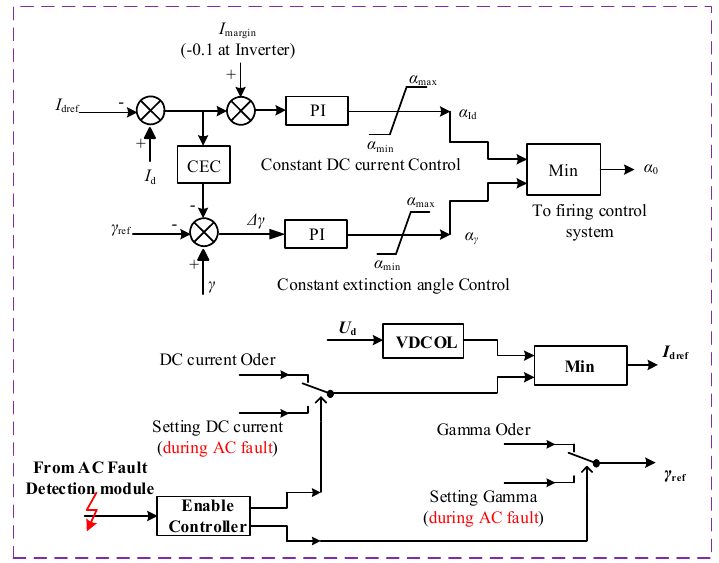
Figure 6. Proposed Control